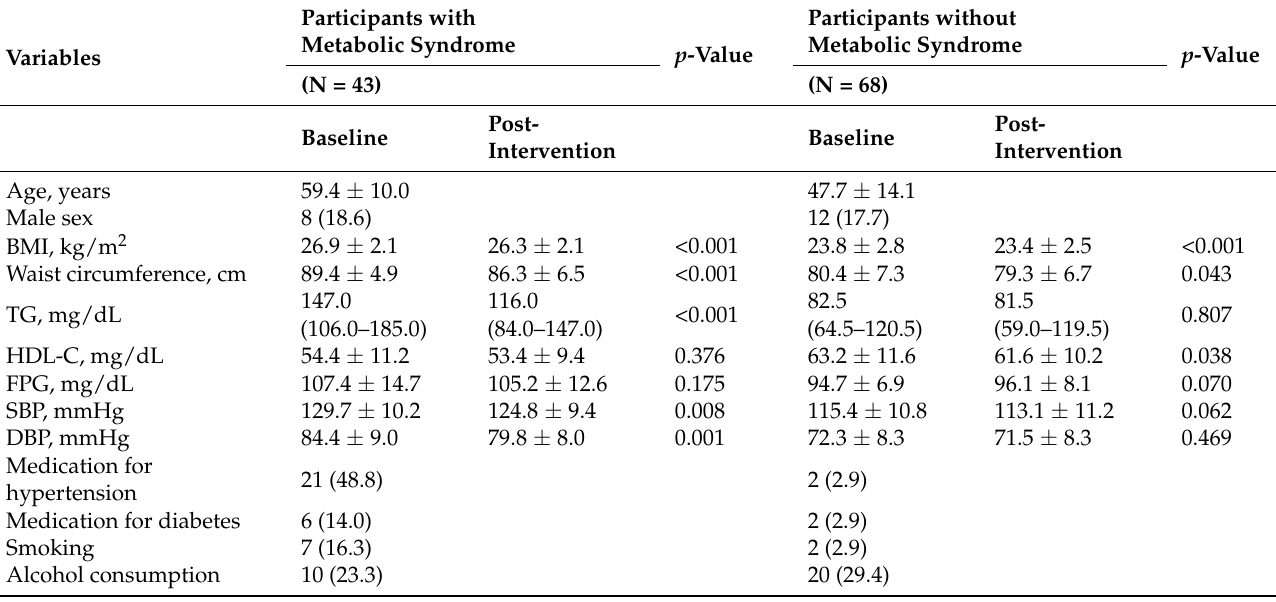
Table 2. Baseline characteristics of participants and outcomes after the lifestyle